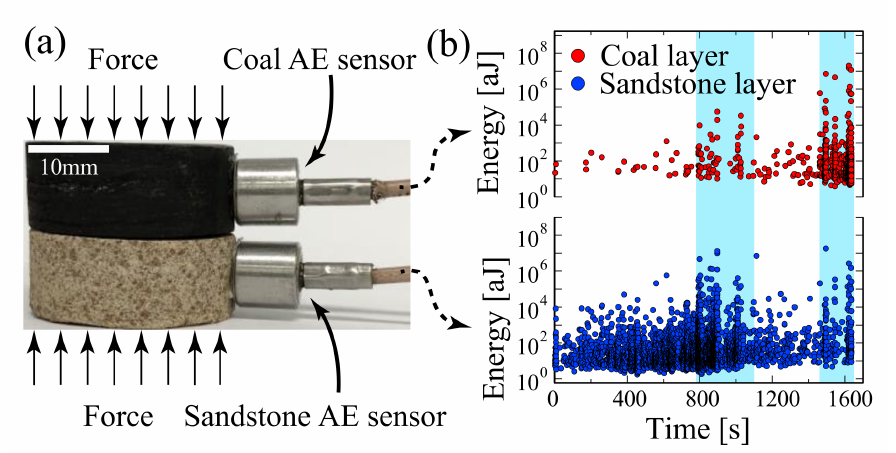
Figure 6. ( a ) Experimental arrangement for high stress measurements. ( b ) Energies of AE hits, detected by the transducers attached to coal and sandstone as indicated by their color as function of time. This experiment contains 1001 events in coal, and 4875 events in sandstone. The shadowed areas indicate time intervals from 790 s to 1100 s and from 1460 s to 1635 s. Reproduced with permission from [71]. American Physical Society,